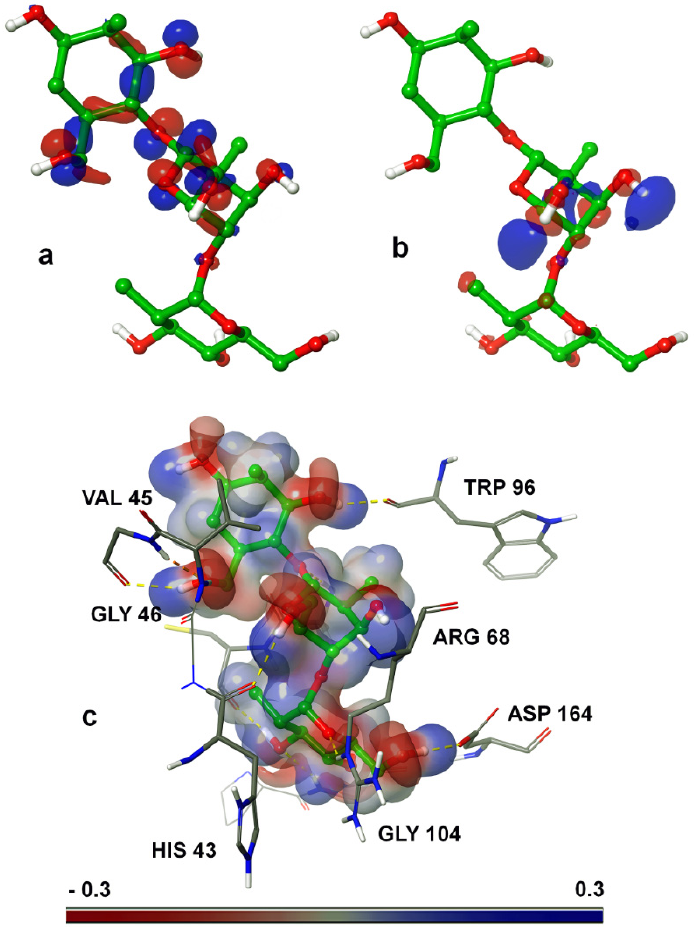
Figure 12. QM-based HOMO/LUMO and MESP charge calculations for the protein and polymer interaction complex. ( a ) Representation of the HOMO, ( b ) representation of the LUMO, and ( c ) representation of the MESP charge in the interval of − 0.3 to 0.3 level charges.